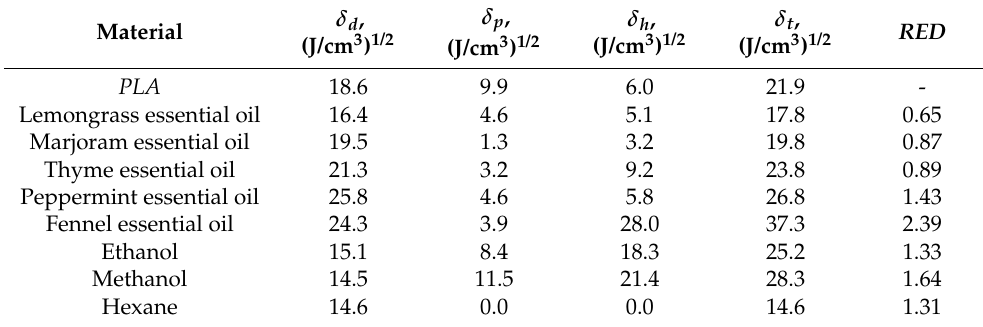
Table 2. Solubility parameters and RED values of essential oils, solvents and the PLA .